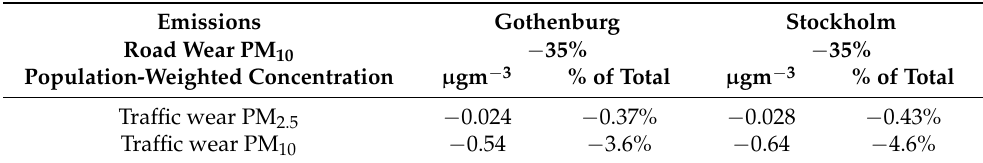
Table 3. Estimated changes relative to baseline due to reduced use of studded tires. In the table header, “% of total” refers to the total concentration in ambient air.